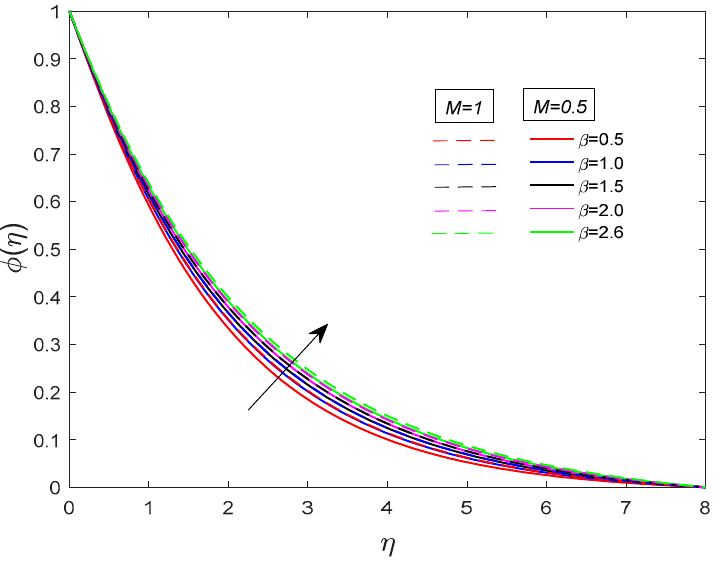
Figure 9. Impact of Maxwell fluid parameter ( β ) on concentration profile with Pr = Sc = 0.7, Ec = Kr = Sr = 0.1.